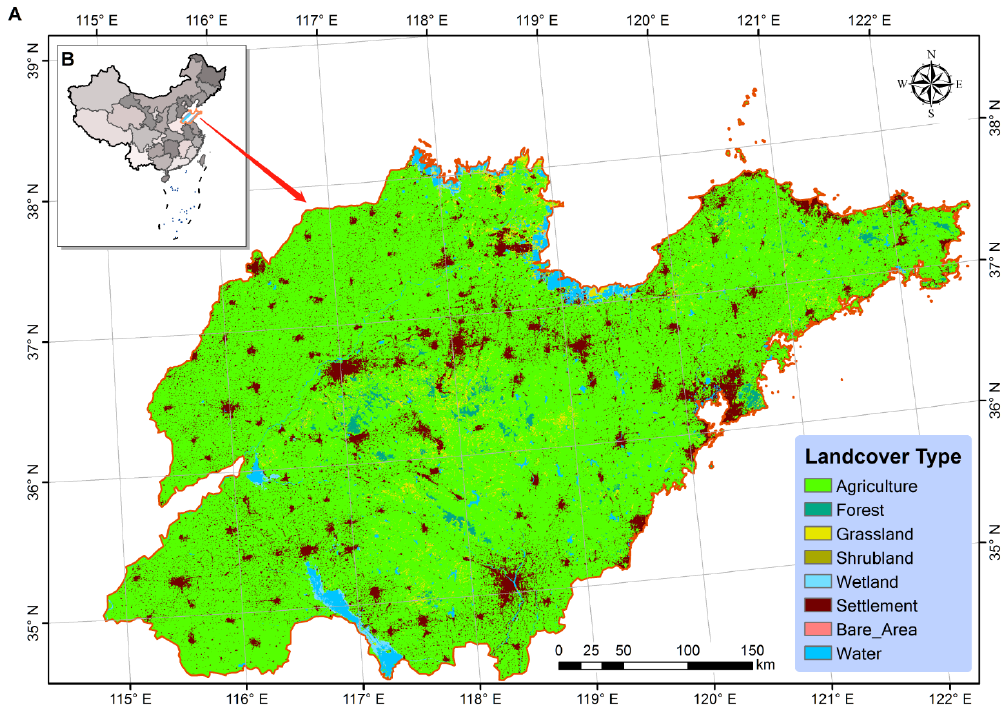
Figure 1. Spatial location of Shandong Province ( A ) in China ( B ). The background map represents the land cover pattern of the study area in 2020 based on the European Space Agency (ESA) Climate Change Initiative Land Cover (CCI-LC)